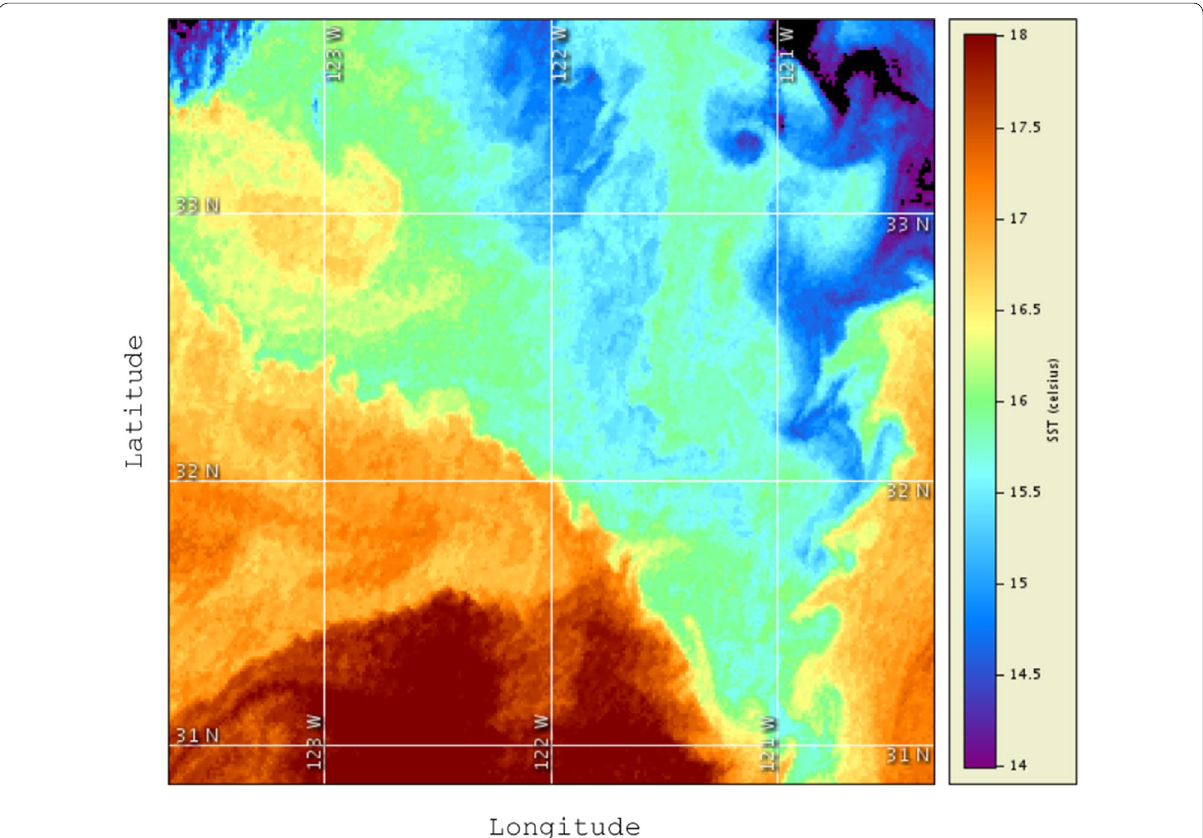
Fig. 2 Sea surface temperature of California. Satellite image on June 3, 2006 (NOAA Coastwatch). Notice the mesoscale contrasts over ≈ 200 km and the submesoscale sharp fronts and filaments on a scale of ≈ 5–10 km. In addition, evident are frontal instabilities (wiggles) and a roll-up into a coherent vortex (in the northeast